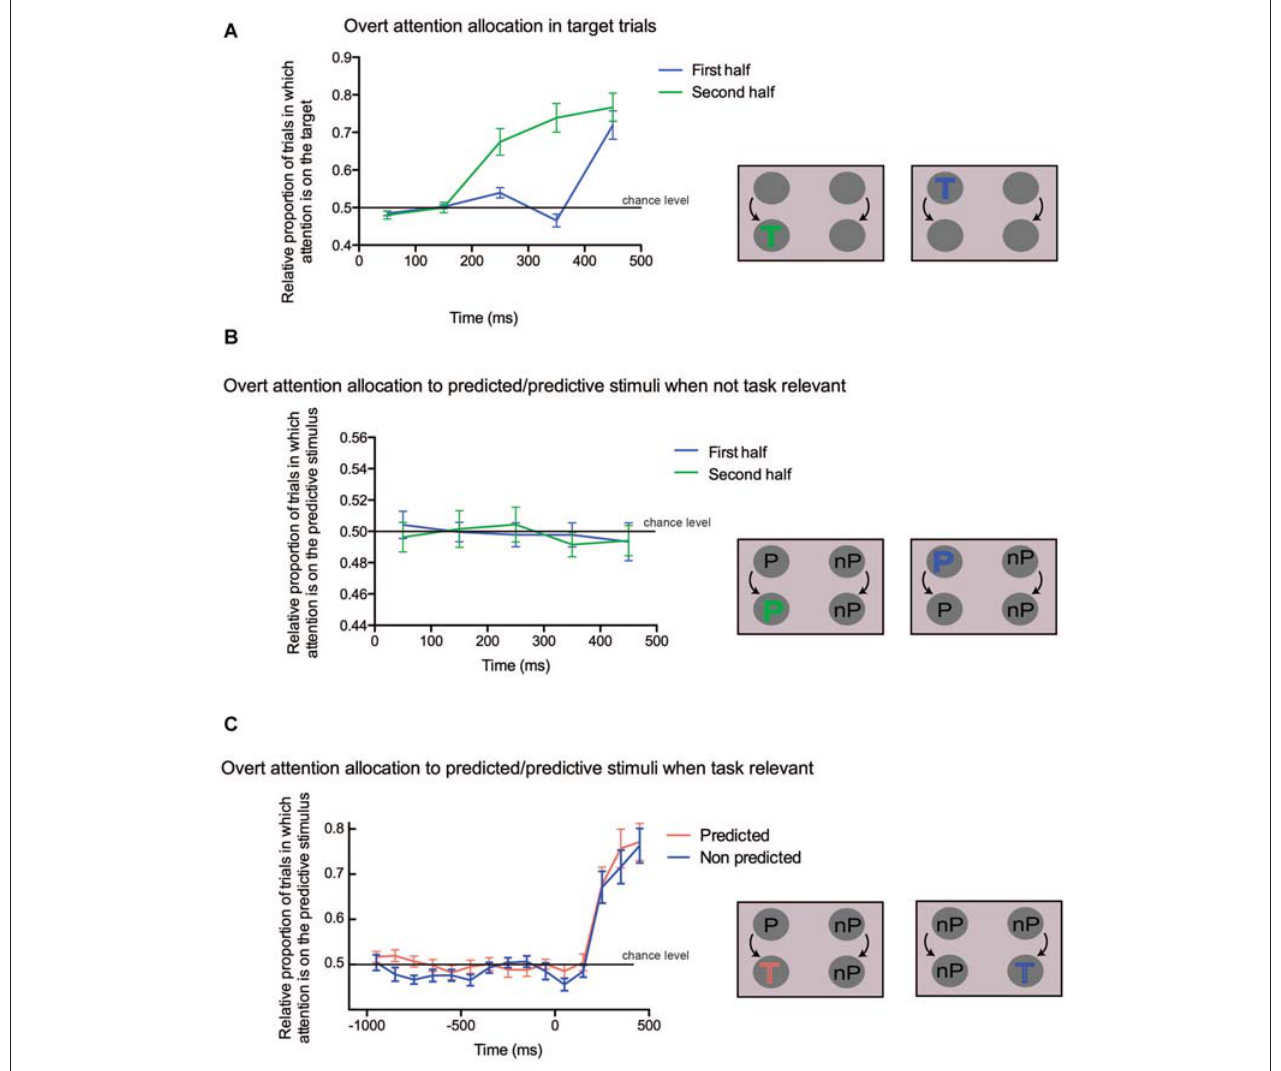
FIGURE 4 | (A) Overt attention allocation for the trials in which a target occurred either in the first half (blue line) or in the second half (green line) of the trial. Time is shown along the x -axis, the proportion of trials in which targets attracted attention is on the y -axis. The 0 value on the x axis corresponds either to the beginning of the trial (first half) or to the change of color (second half). A schematic depiction of the analyzed conditions is shown on the right. The target could appear either in the first part (blue “T”) or in the second part (green “T”). (B) Overt attention allocation to predicted/predictive stimuli when not task-relevant. On the x -axis time is in ms, on the y -axis the proportion of trials in which predictive colors attracted attention is shown, indicated as the difference between the predicted and the non-predicted dots. A value of 0 on x -axis corresponds either to the beginning of the trial (first half) or to the change of color (second half). On the right, the predicted (“P”) and non predicted (“nP”) conditions are illustrated. (C) Overt attention allocation to the predicted stimulus when task relevant. On the x -axis time is in ms, while on the y -axis there is the relative proportion of trials in which attention is captured by the predictive stimulus when the target is either predictive or not. A value of 0 on the x -axis corresponds to the time of the change of color. The two conditions are illustrated on the right of the panel: in the first case the target is preceded by a predictive color (red “T”), whereas in the second case the target is preceded by a non-predictive color (blue “T”).